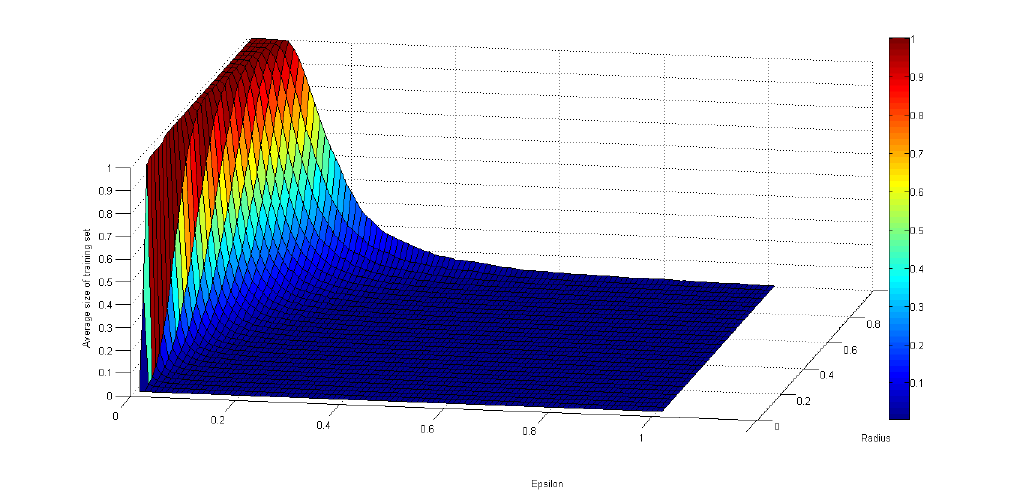
Figure 3. Percentage size of granulated data, 5 × CV5 test, ε concept-dependent granulation; Wisconsin Diagnostic Breast Cancer data set; Epslilon = is descriptors indiscernibility ratio, Radius = granulation